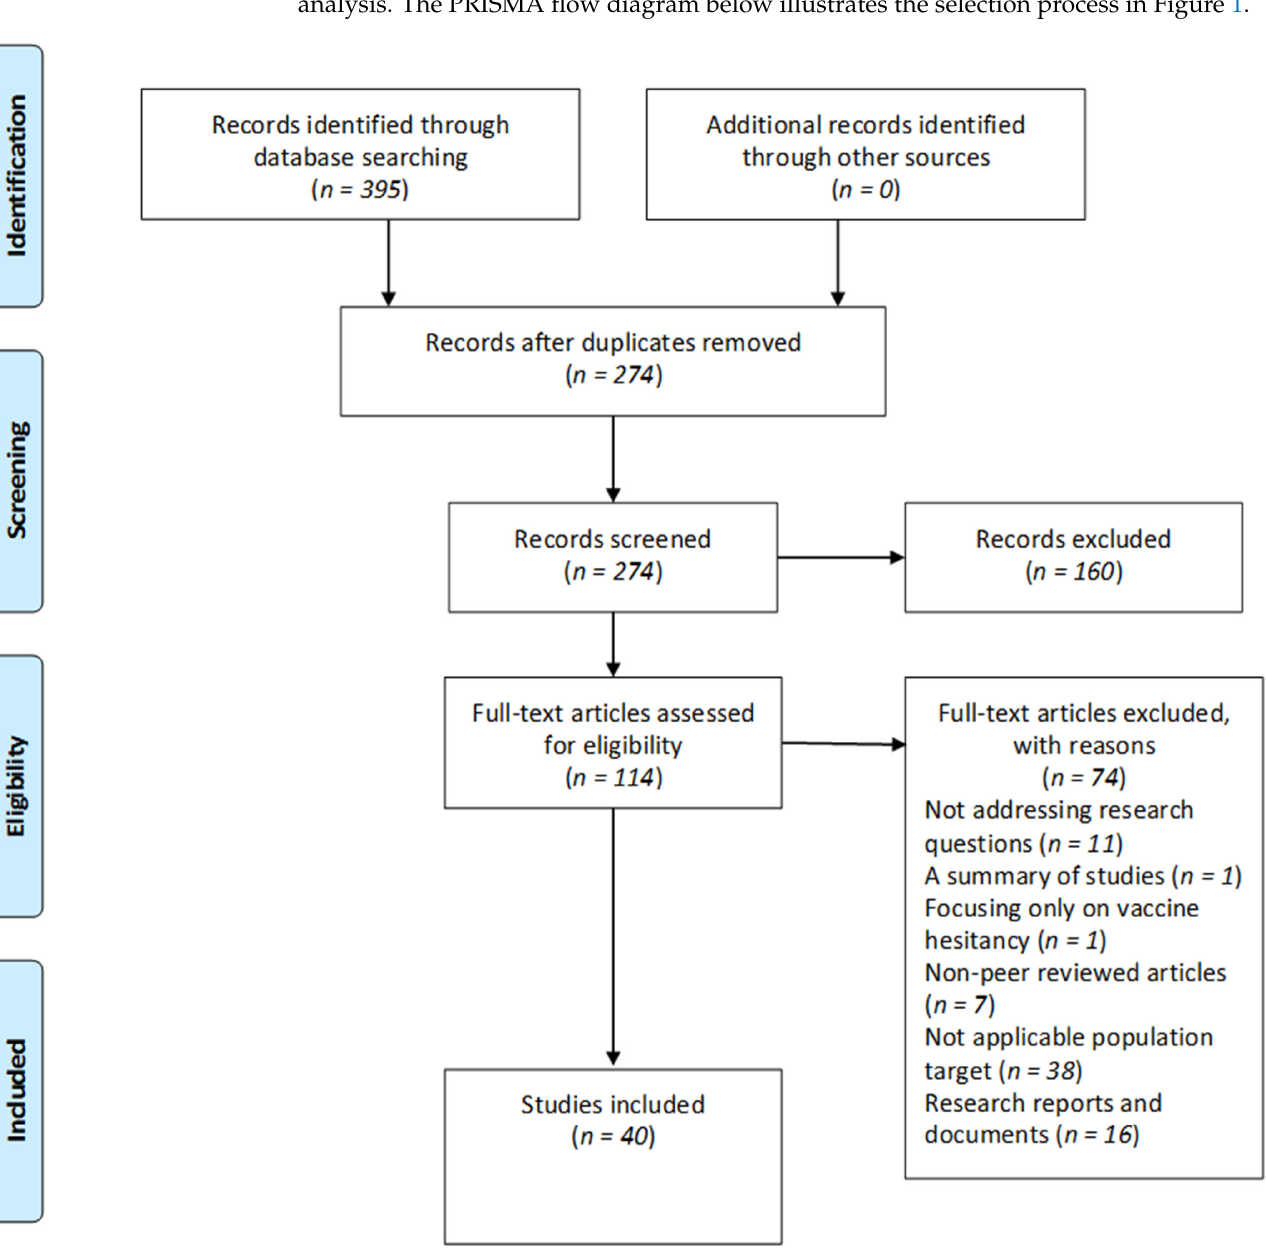
Figure 1. PRISMA flow diagram: selection of included studies.